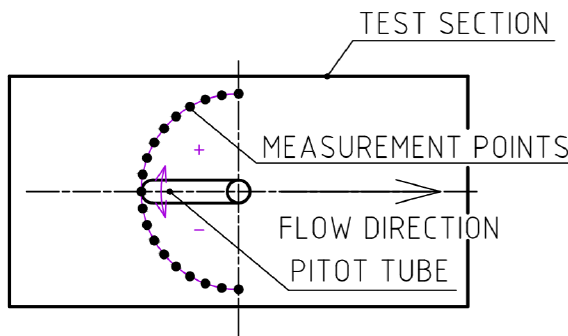
Fig. 18. L-type and S-type pitot static tubes design .